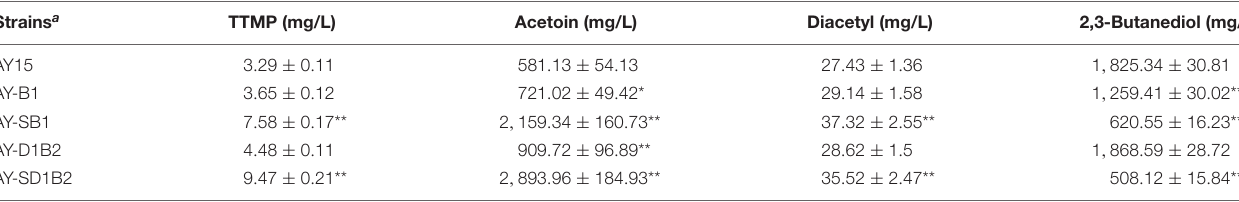
a Diploid strain: AY-B1 (BDH1 single-allele-deletion), AY-SB1 (BDH1 double-allele-deletion), AY-D1B2 (BDH1 single-allele-deletion and BDH2 single-allele-overexpression), and AY-SD1B2 (BDH1 double-allele-deletion and BDH2 double-allele-overexpression). The strains were fermented by corn-semi-solid medium at 30 ◦ C for 4 days. Values are means ± standard deviations from at least three independent tests. Statistical significance is denoted as **P < 0.01 and *P < 0.05.